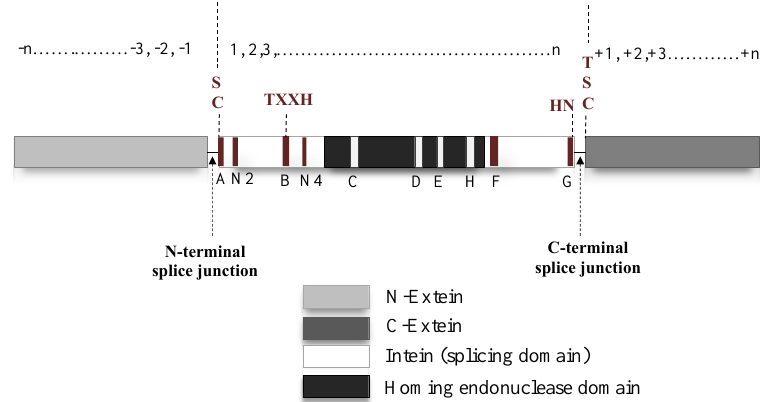
Figure 3. Schematic diagram displaying different structural domains of precursor protein. Intein insertion divides the host protein into N-extein (light grey) and C-extein (dark grey). Intein has two domains: splicing domain (white) and homing endonuclease domain (HED) (black). Residues on the intein and exteins are numbered as follows; Intein residues (1, 2, ... n), N-extein residues ( − 1, − 2, ... − n) and C-extein residues ( + 1, + 2, ... + n). Centrally located endonuclease domain carries C, D, E and H conserved Blocks (motifs). N-terminal intein contains A, N2, B, and N4 Blocks (maroon Blocks), while F and G-Blocks (maroon Blocks), are seen in the C-terminal intein. Conserved residues within these regions either directly participate or assist in the cleavage and splicing